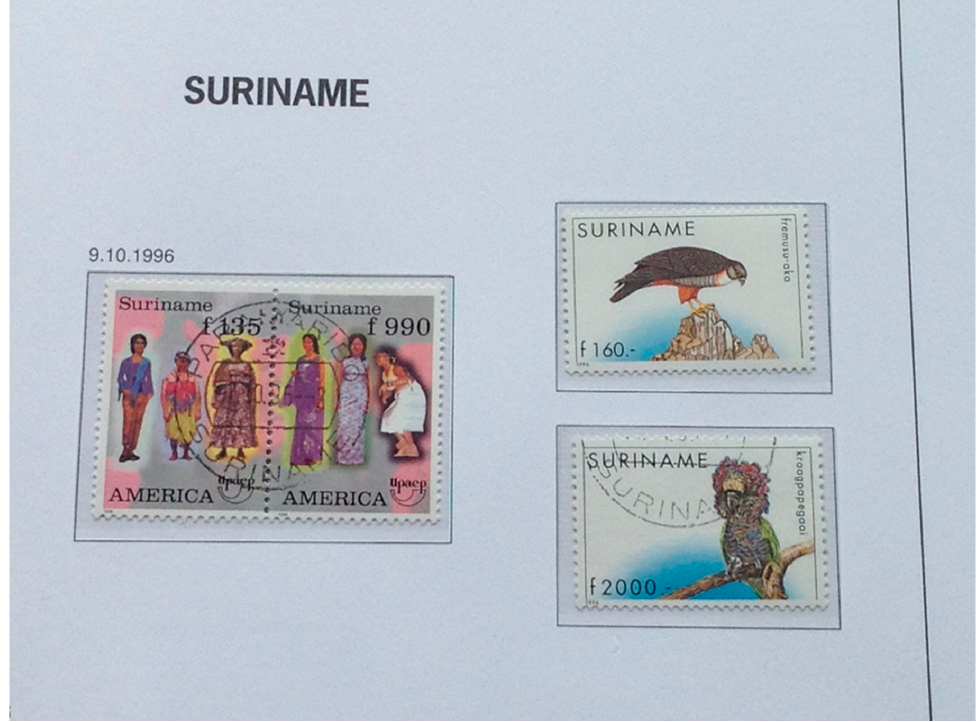
Figure 1. A few stamps issued in 1996 in Suriname (with exceptionally high prices).